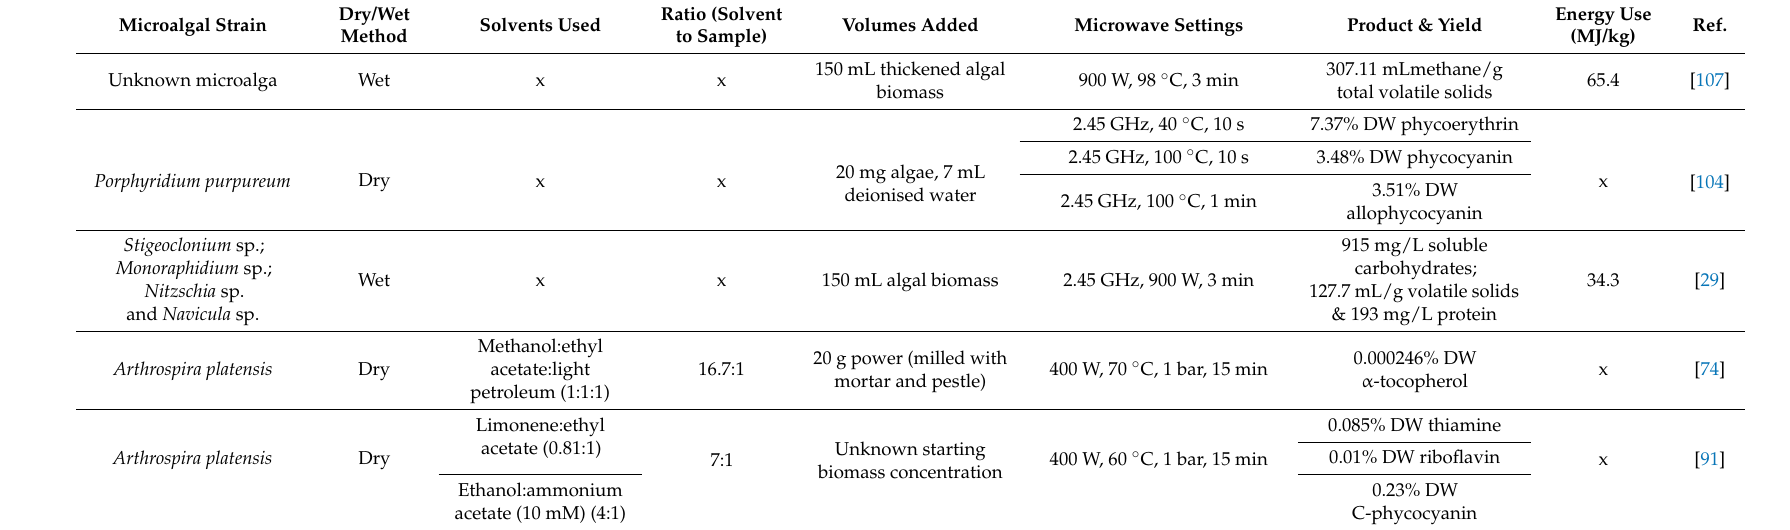
Table 5. Other high-value products extracted from microalgae by